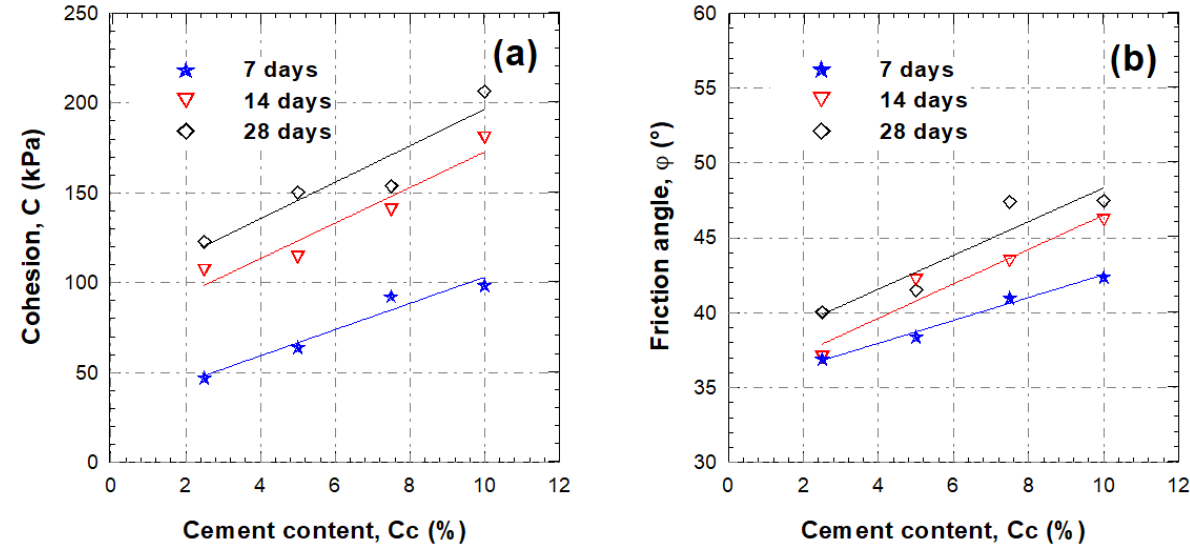
Figure 12: Influence of curing time on the mechanical characteristics of cemented